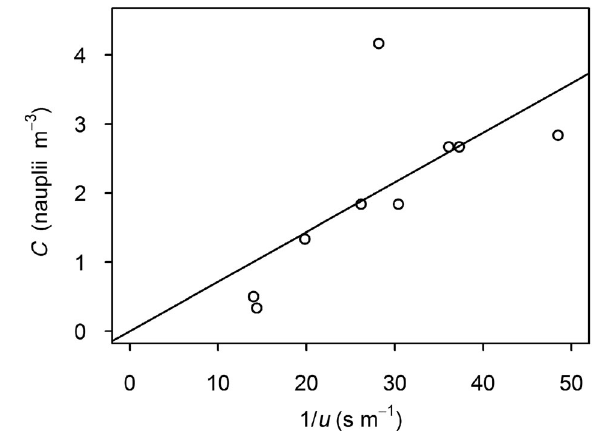
Fig. 6. Lepeophtheirus salmonis nauplii abundance C rela- tive to the inverted current speed 1/ u perpendicular to the cage at 1 m depth. The line denotes the linear relationship between current speed and nauplii abundance C = 0.072 (1/ u ) (R 2 = 0.87, p <